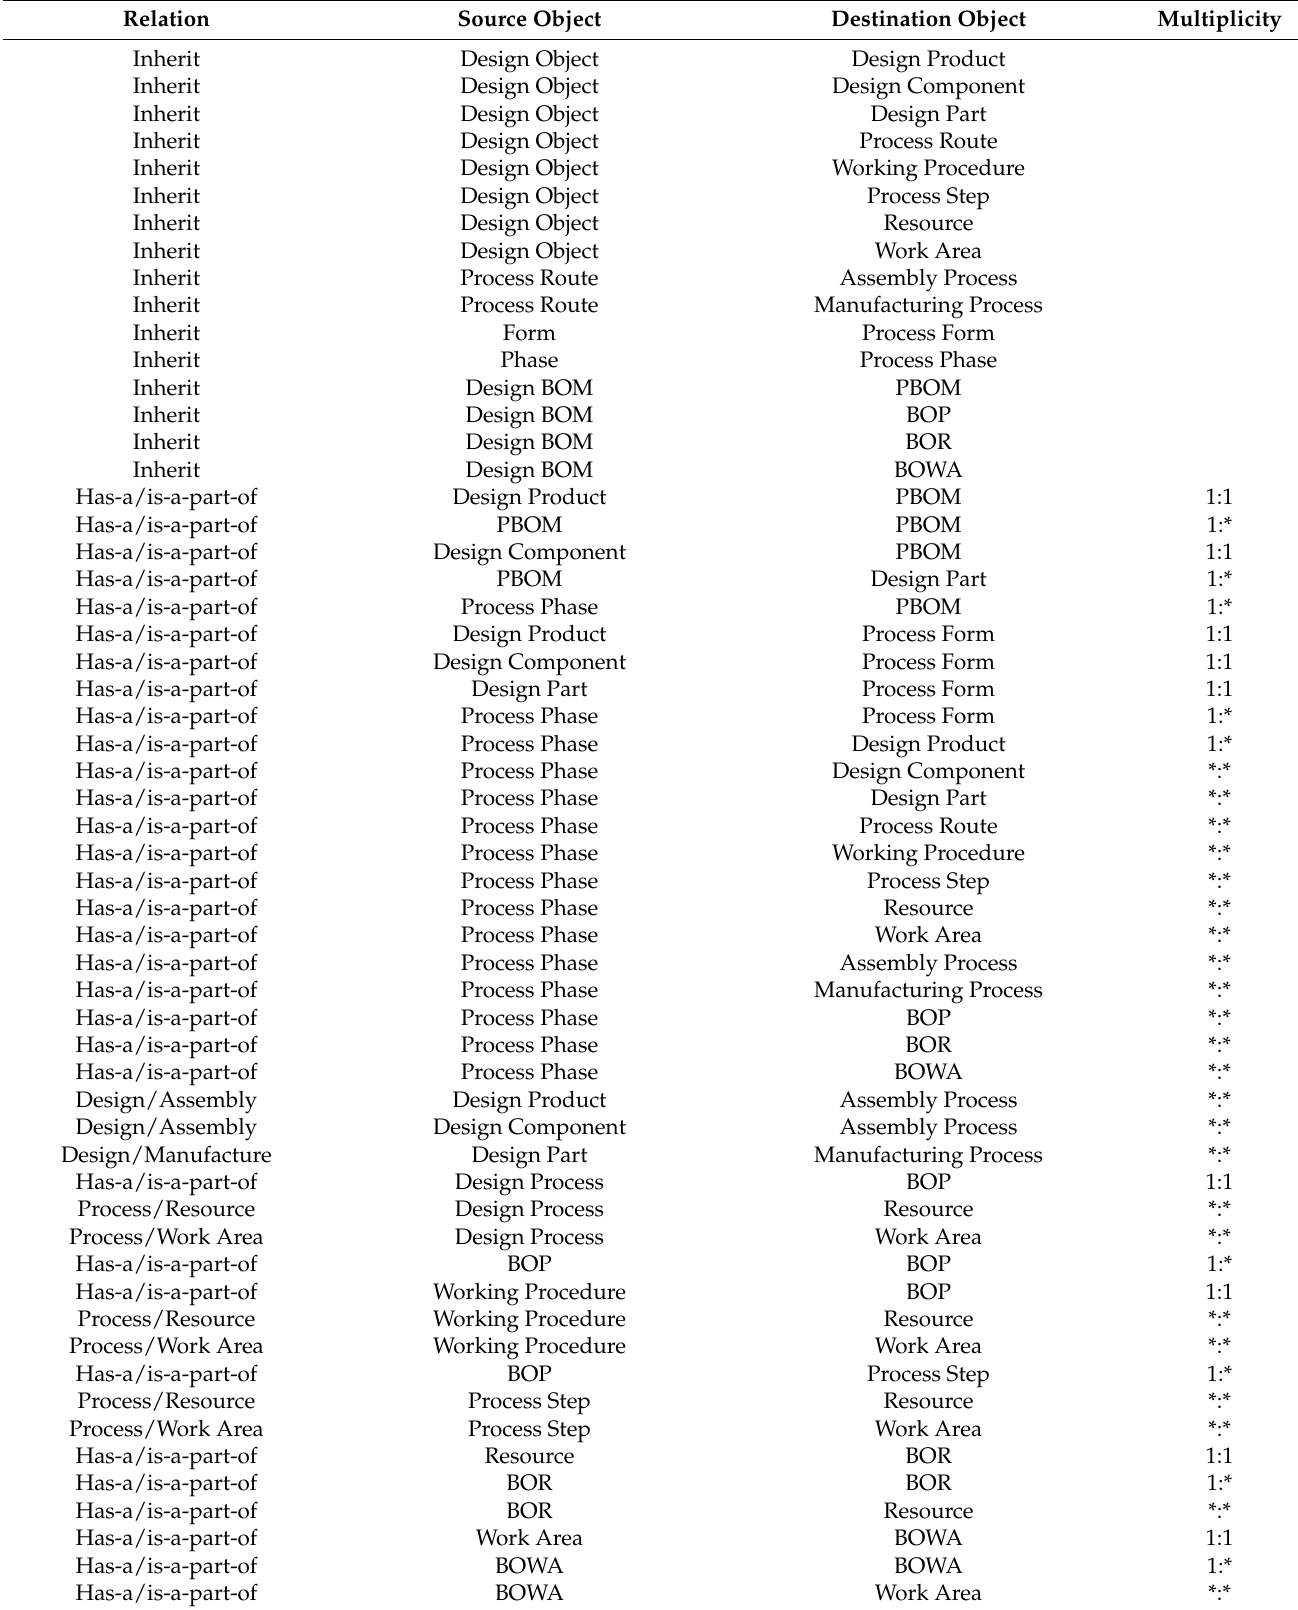
Table 7. The set of rules in the process phase (1, * represent the one and